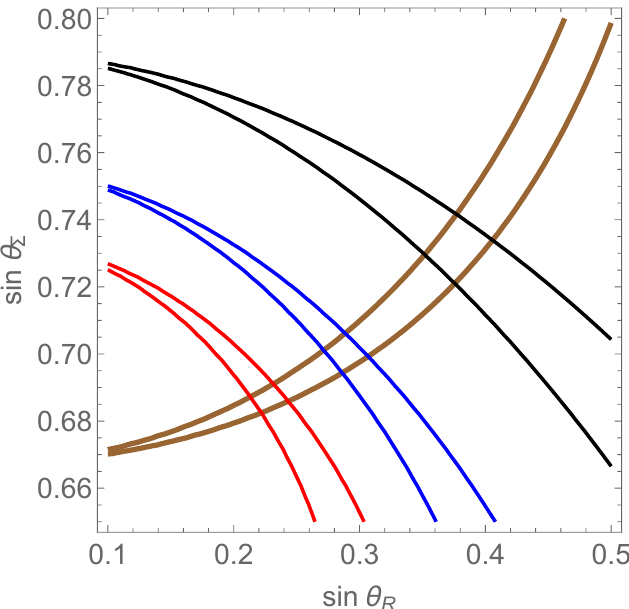
(brown lines, as obtained in L (cid:28) R (cid:28) R